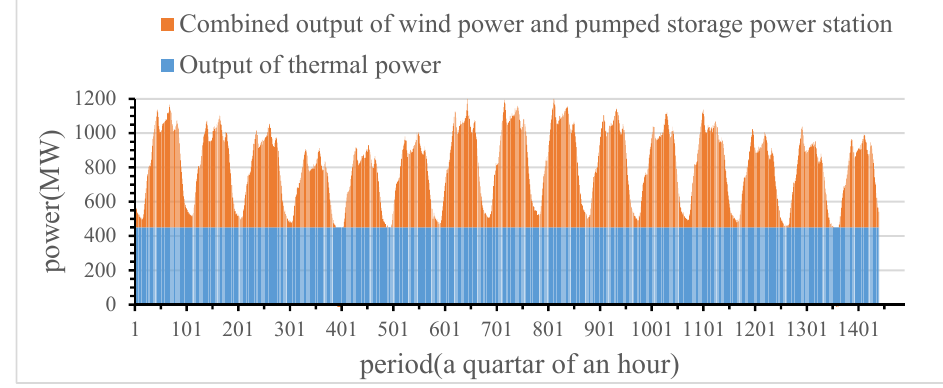
Figure 10. The load composition in heating peak period.